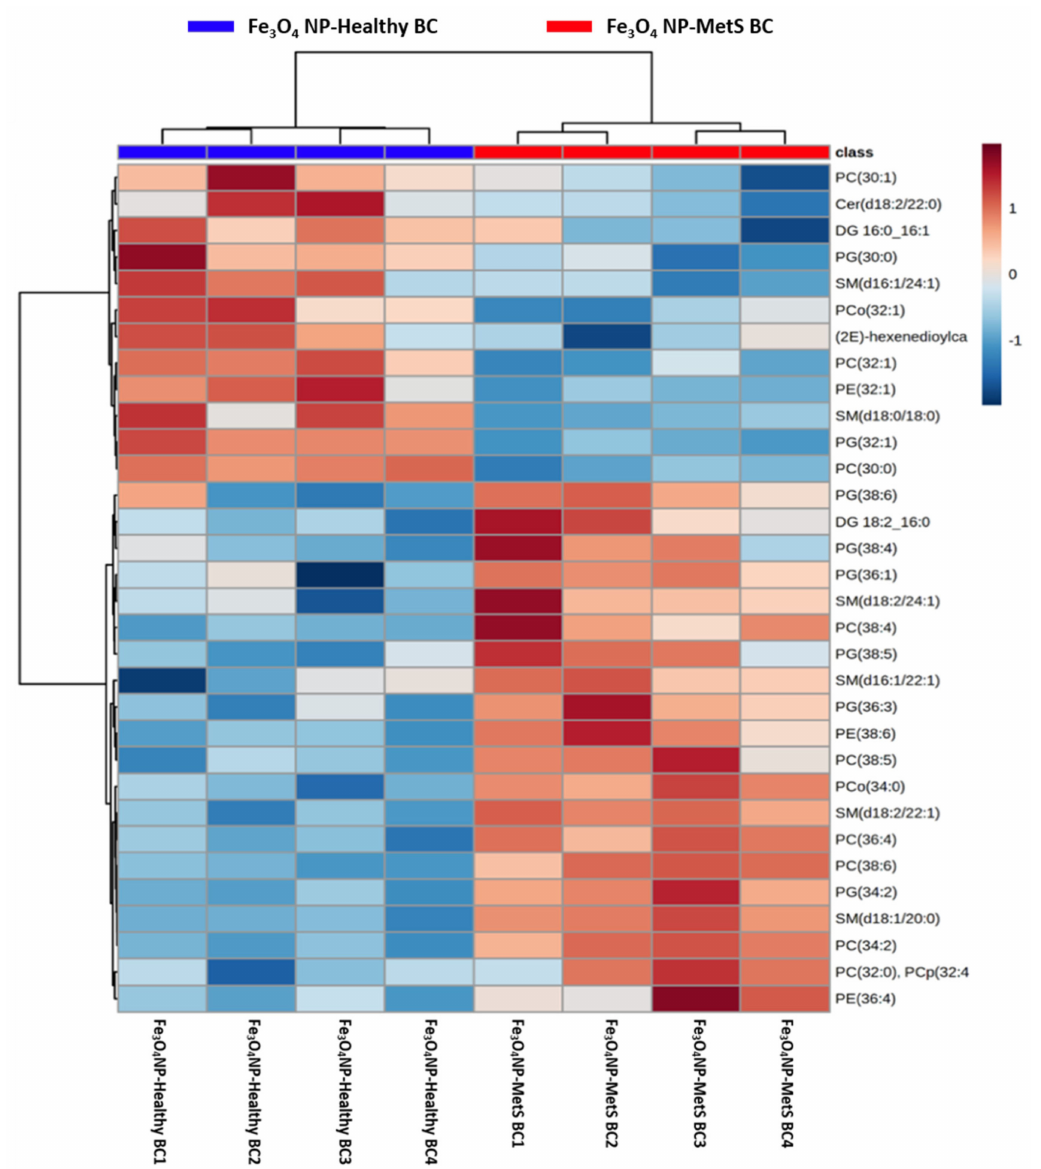
Figure 3. Relative abundance of lipids associated with healthy and MetS BCs. Lipids identified as present within the BCs in healthy and MetS conditions were compared based on their abundance ( p < 0.05, n = 4/group). A heatmap provides intuitive visualization of differences between two BCs. Each colored cell on the map corresponds to a relative abundance of each lipid in the sample, with samples in rows and lipids in columns. Red denotes a higher concentration of the lipid in the sample, while blue denotes less lipid found in the sample compared to mean value of all samples from both groups. A comprehensive list of relative abundance differences for all lipids in BCs can be found in Table